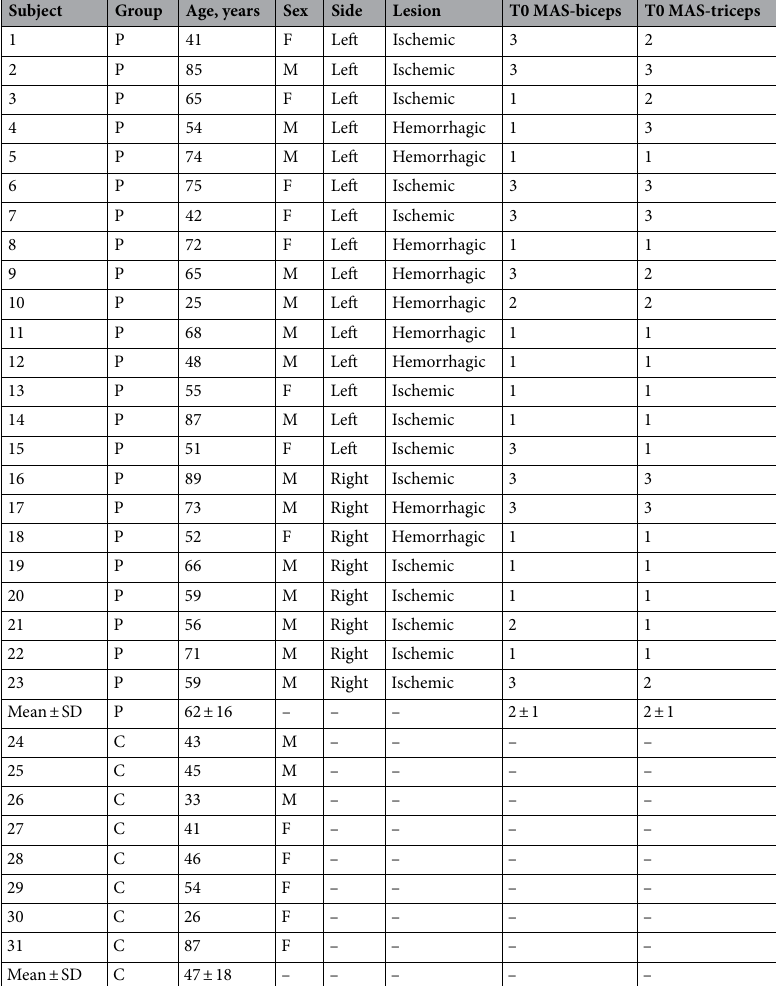
Table 1. Demographic and anthropometric data for the study